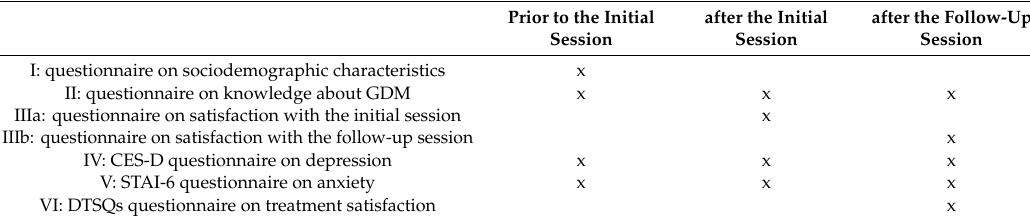
Table 1. Overview of the di ff erent self-administered questionnaires at the di ff erent visits.